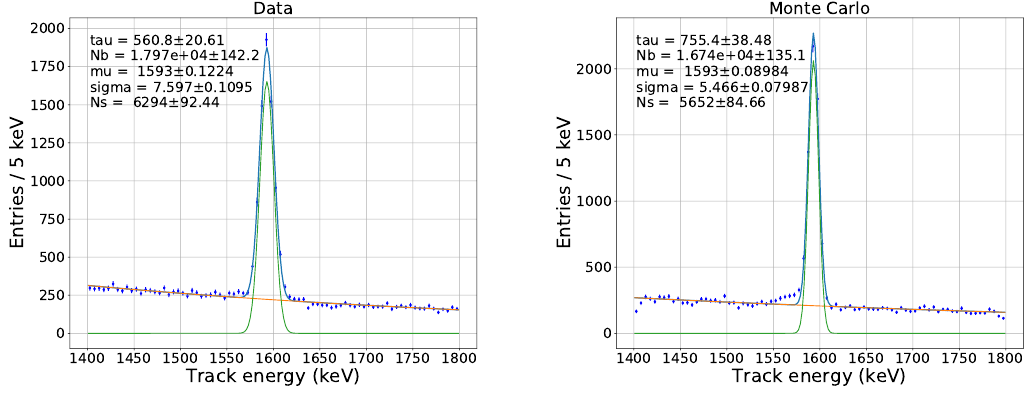
Figure 8 . Energy spectrum and results of the gaussian+exponential (cid:12)t for both data (left) and Monte Carlo